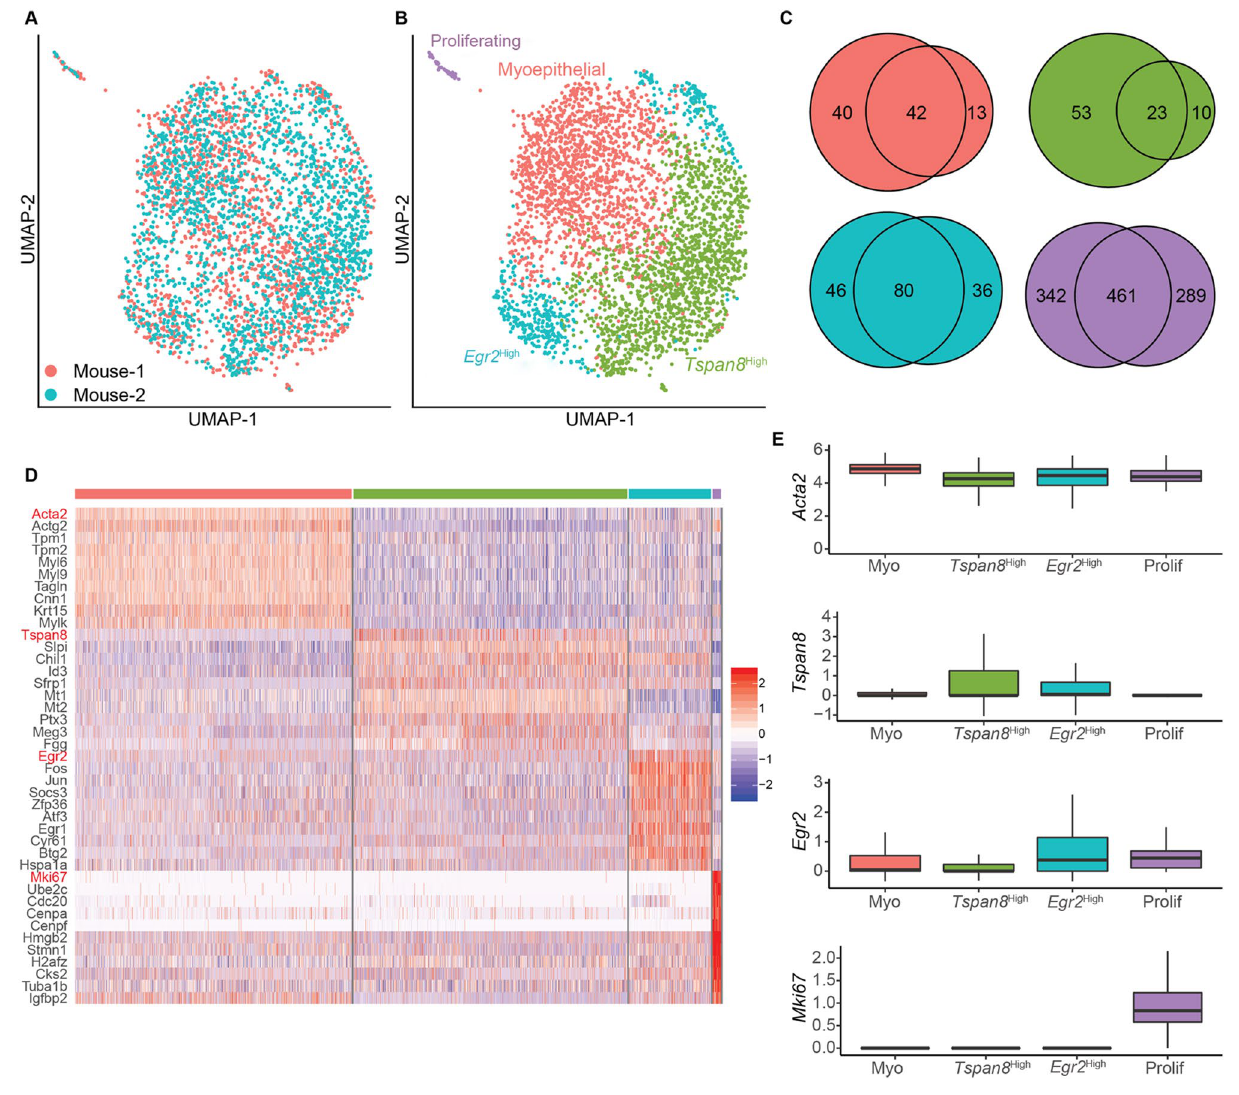
Figure 1. Identification of four major transcriptional states in basal cells of adult virgin mammary gland. ( A ) UMAP projection of mammary basal cells colored by mouse. ( B ) UMAP projection as in ( A ) colored by transcriptional state. ( C ) Venn diagram showing overlap in marker genes for the transcriptional states identified in both mice. Each circle represents the number of marker genes for a particular transcriptional state [same color code as in ( B )] in each mouse. ( D ) Heatmap of top 10 marker genes for each transcriptional state identified in ( B ). ( E ) Boxplots of the indicated marker genes (marked in red in D ) across all four basal transcriptional